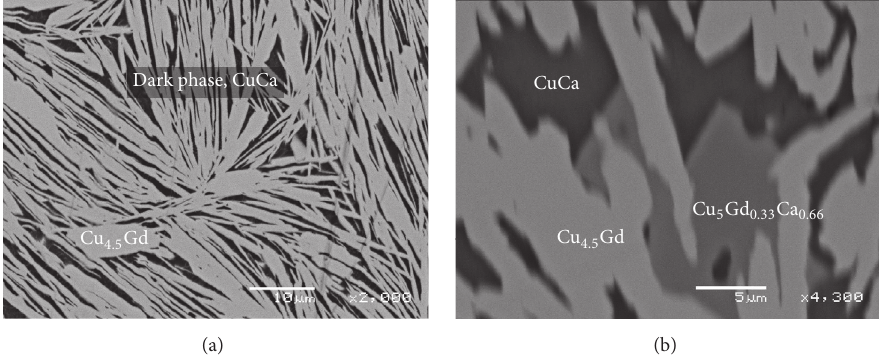
Figure 2: Backscattered SEM images of polished surface of (a) arc-melted Cu 5 Gd 0.5 Ca 0.5 sample, and (b) the same sample after 7 days of homogenization at 700 ∘ C in an argon-filled sealed silica tube and subsequently ice-water quenched.